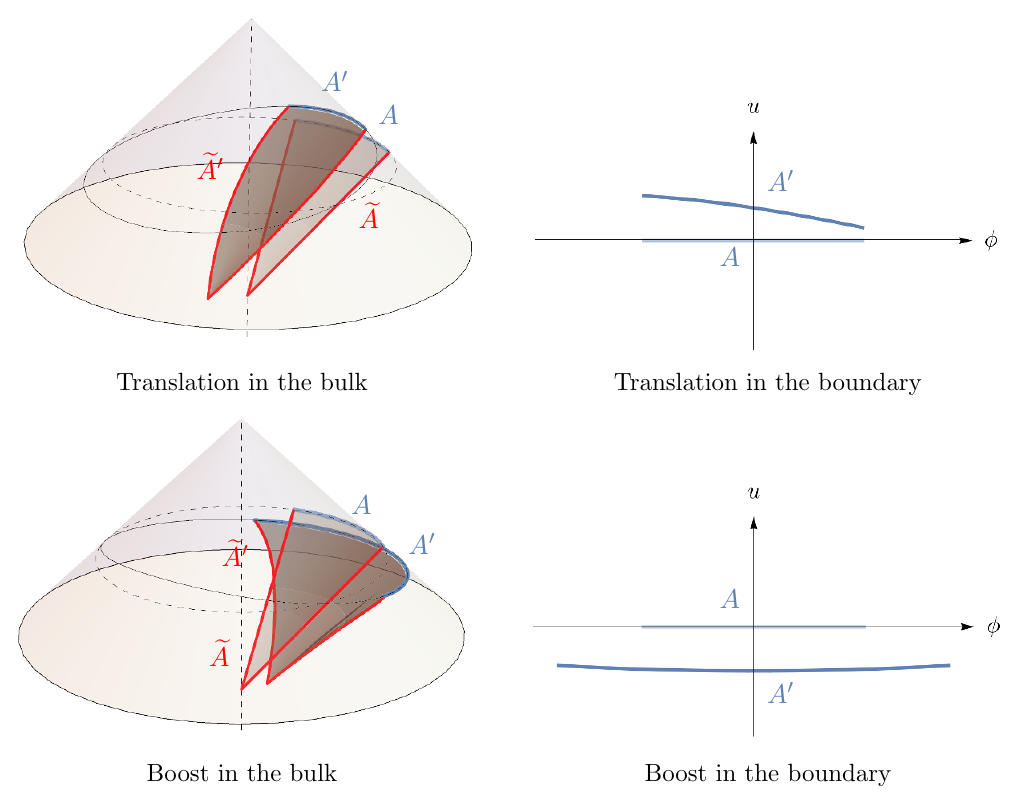
Figure 4 . Examples of new RT surfaces obtained by bulk isometries acting on the reference con(cid:12)guration for ‘ u =